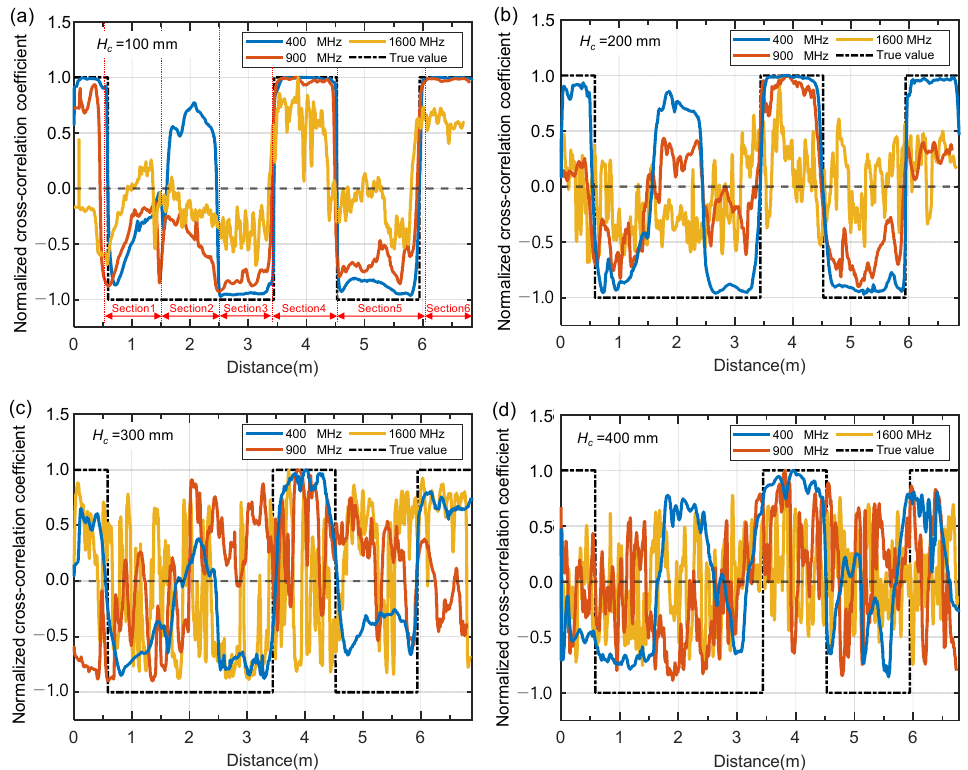
Figure 10. Variation of cross-correlation coefficient of GPR signals measured by the three GPR antennas (400 MHz, 900 MHz, and 1600 MHz) over various test sections in the concrete specimens with various concrete thicknesses, H c : ( a ) 100 mm, ( b ) 200 mm, ( c ) 300 mm, and ( d ) 400 mm.